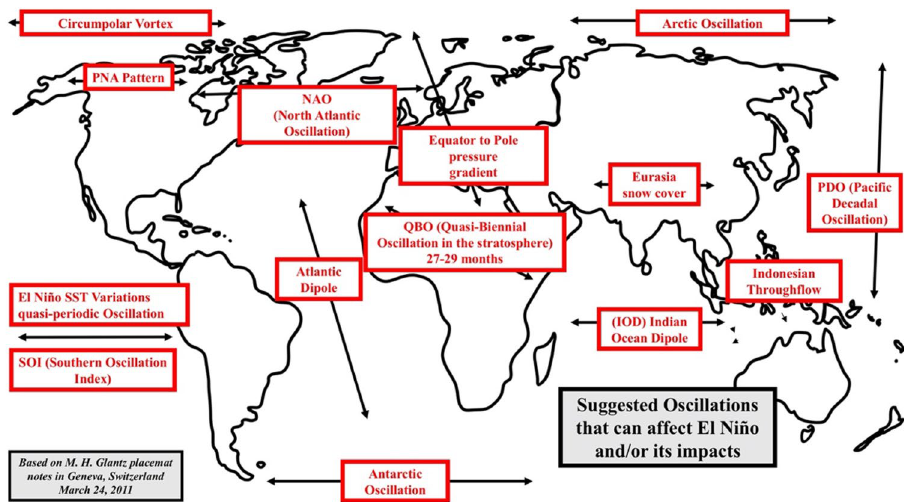
Fig. 6 Oscillations that can affect the societal and eco- logical impacts of ENSO’s extremes. Source Ross